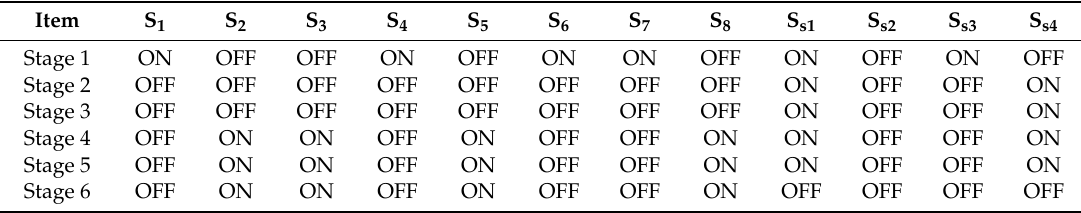
Figure 3. Key waveforms: ( a ) secondary side modulation; ( b ) primary side modulation. Table 1. Switching scheme in the first half switching period (secondary side modulation mode).